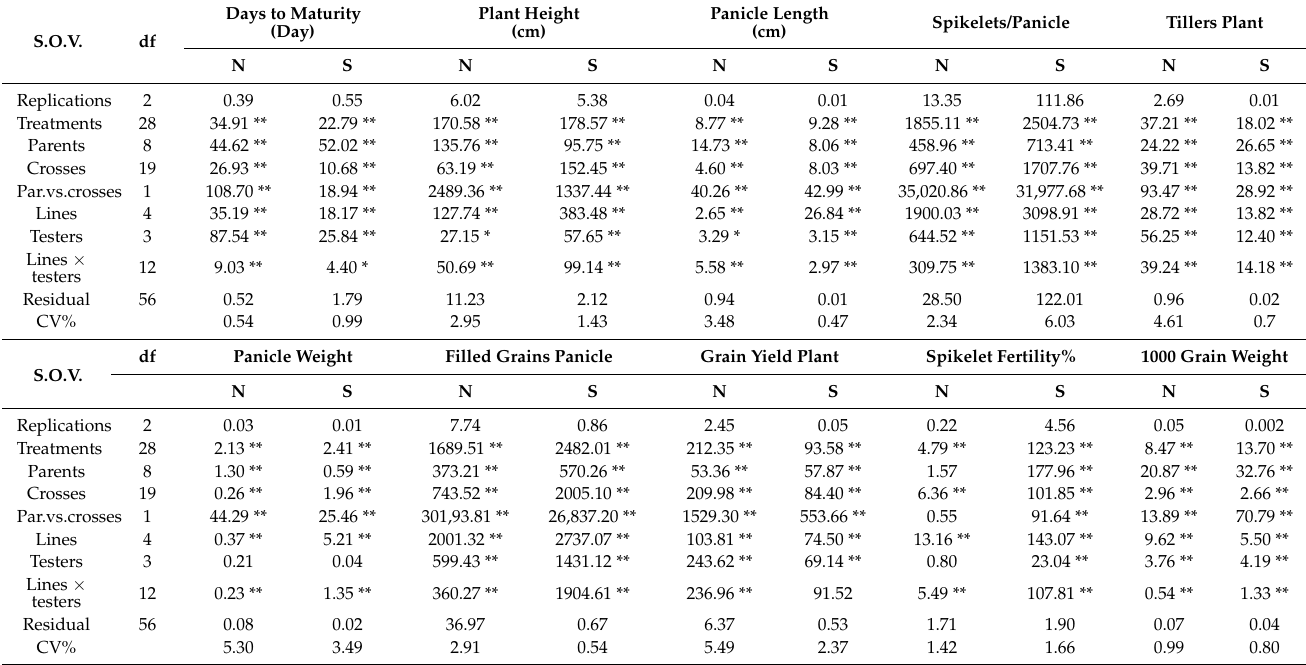
Table 1. Analysis of Variance of the Line × Tester Mating Design for 10 Yield Characteristics under Normal and Water-Stress